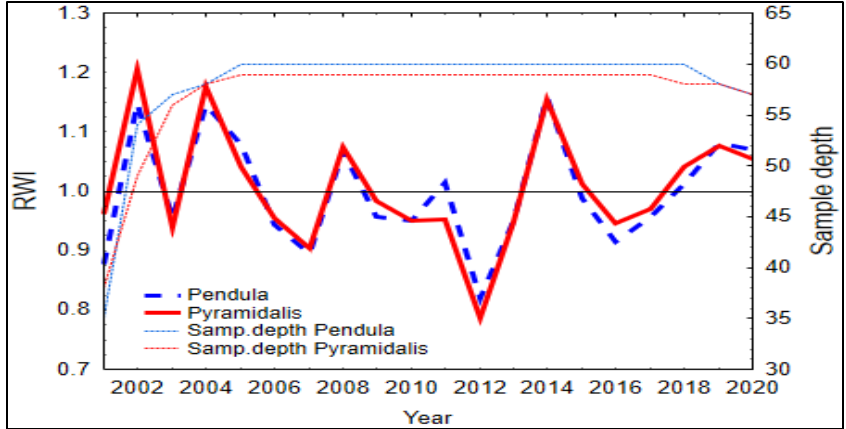
Figure 3. Master chronology of standardized ring-width indices (RWI) of the two Norway spruce forms. Samp. = Sample.